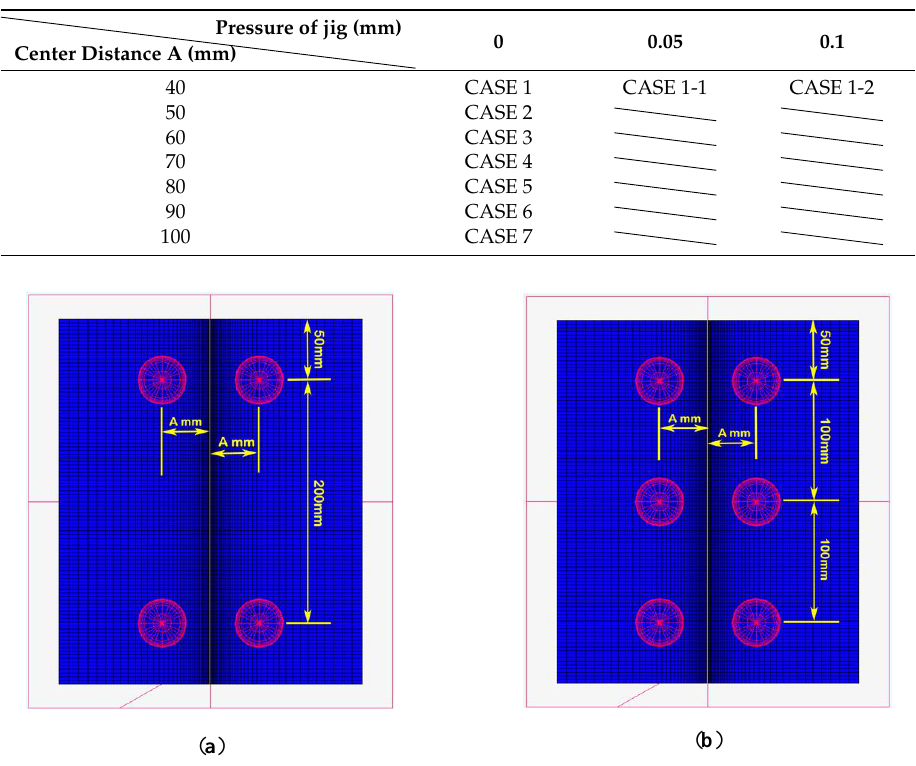
Figure 13. Applied jigs and positions before welding: ( a ) four jigs; ( b ) six jigs.